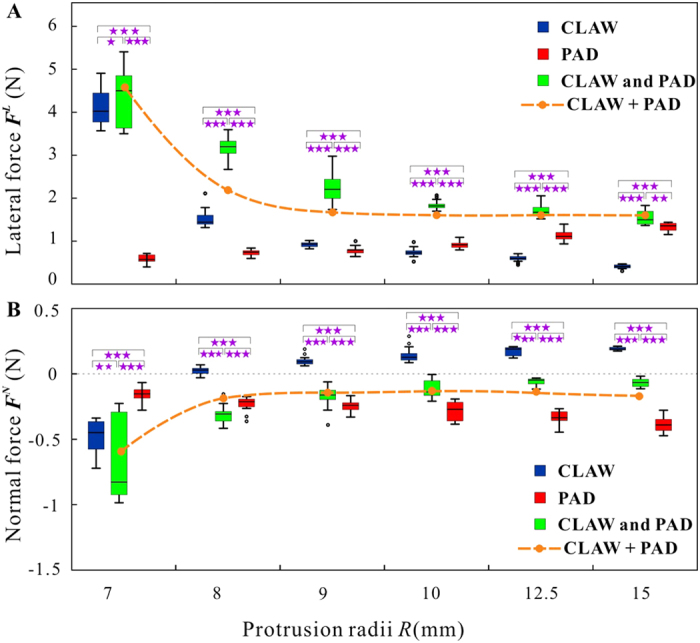
The peak forces on different diameters of spherical protrusions.(A) The lateral forces of the claw, adhesive pad and combined device. (B) The normal forces of the claw, adhesive pad and combined device. Significance levels: *P > 0.05, **P < 0.05, ***P < 0.001.